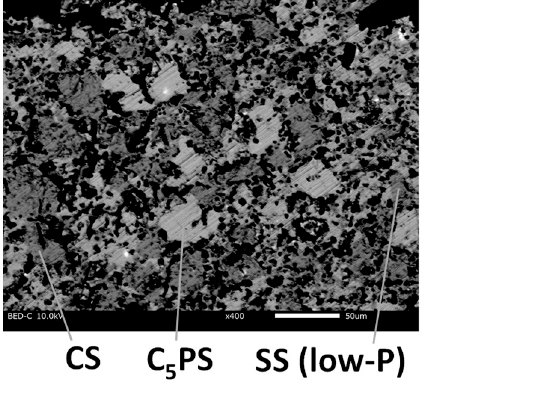
Figure 4. SEM image of M2-0 ( left ) and phase composition projected on an isothermal section of the CaO-SiO 2 -P 2 O 5 ternary phase diagram at 1573 K ( right ).